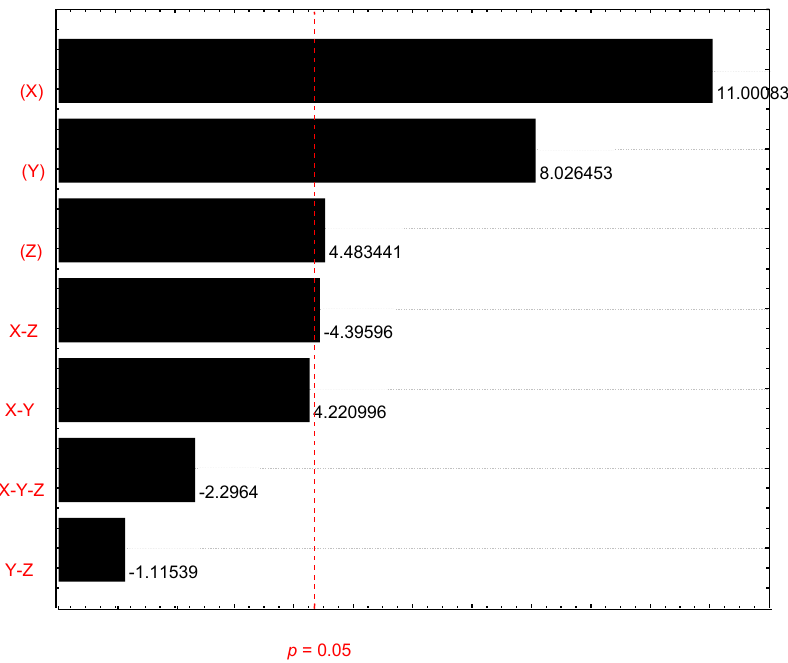
Figure 3. Pareto chart for variables. Total aflatoxin reductions (%) after O 3 exposure. The moisture content percentile of the samples did not di ff er ( p > 0.05) between treated and control samples, varying from 8.6 to 9.5. Aw also did not di ff er, with the overall mean corresponding to